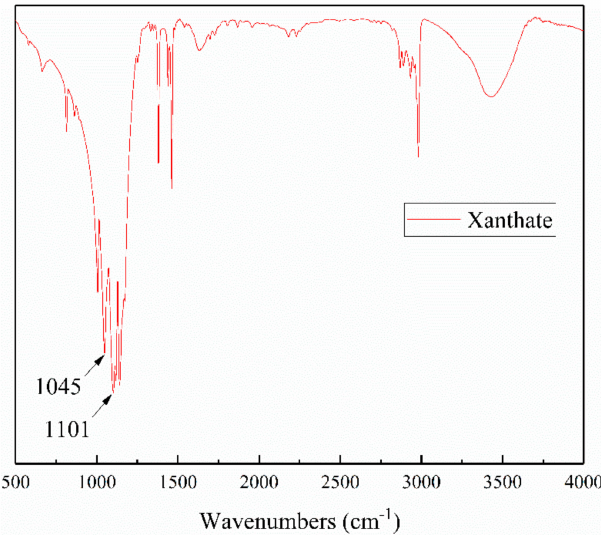
Figure 8. FTIR of